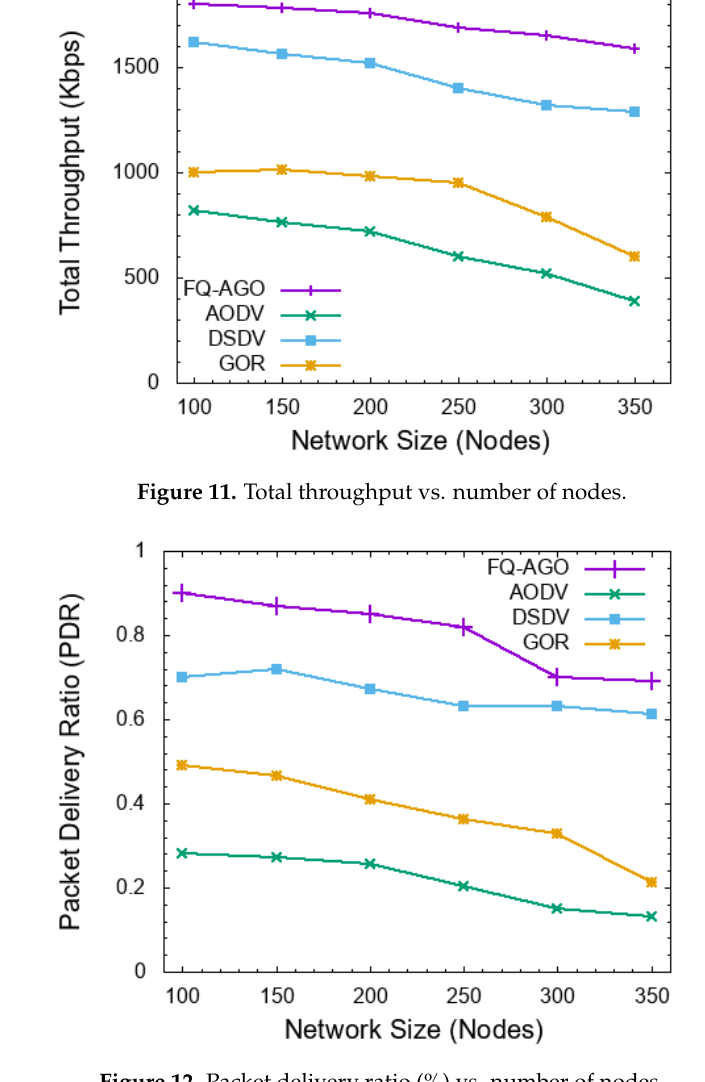
Figure 12. Packet delivery ratio (%) vs. number of